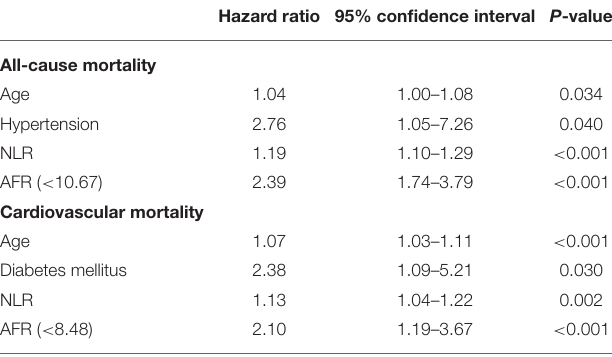
TABLE 2 | Independent factors correlated with all-cause and cardiovascular